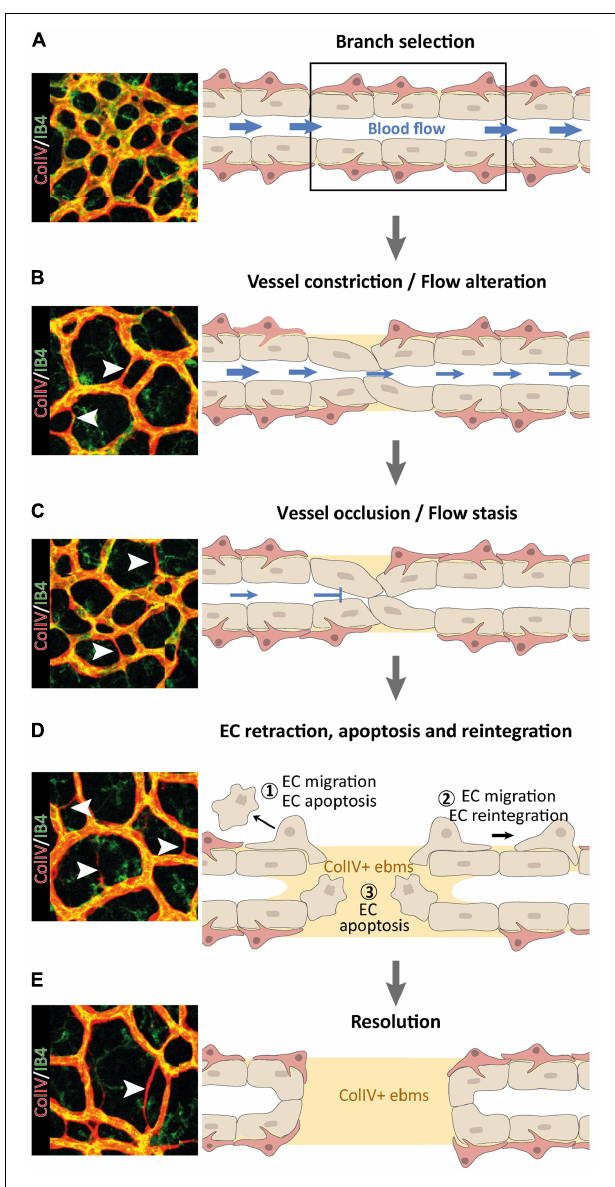
FIGURE 1 | Multi-step nature of vessel pruning and regression processes, reproduced from Korn and Augustin (2015). (A–D) Following the primarily blood flow-driven selection of a BV branch for regression (A) , the BV constricts (B) until it occludes (C) and the blood flow ceases (D) . ECs within regressing vessel segments may retract and undergo apoptosis (1), or they may migrate away to re-integrate elsewhere (2), leaving behind collagen V (ColIV) + empty basement membrane sleeves (ebms). Retracting ECs can disintegrate from the vascular network and undergo EC apoptosis due to detachment from the basement membrane (3). (E) In a final resolution step, regression of the selected BV branch is completed, leaving a remodeled vascular network